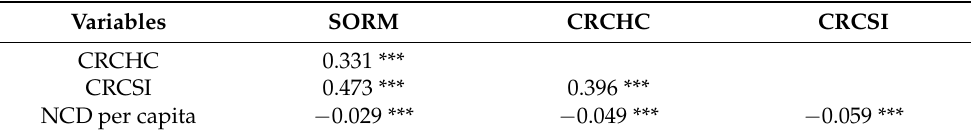
Table 4. Spearman’s correlation analysis on the relationships between SORM, CRCHC, CRCSI, and NCD per